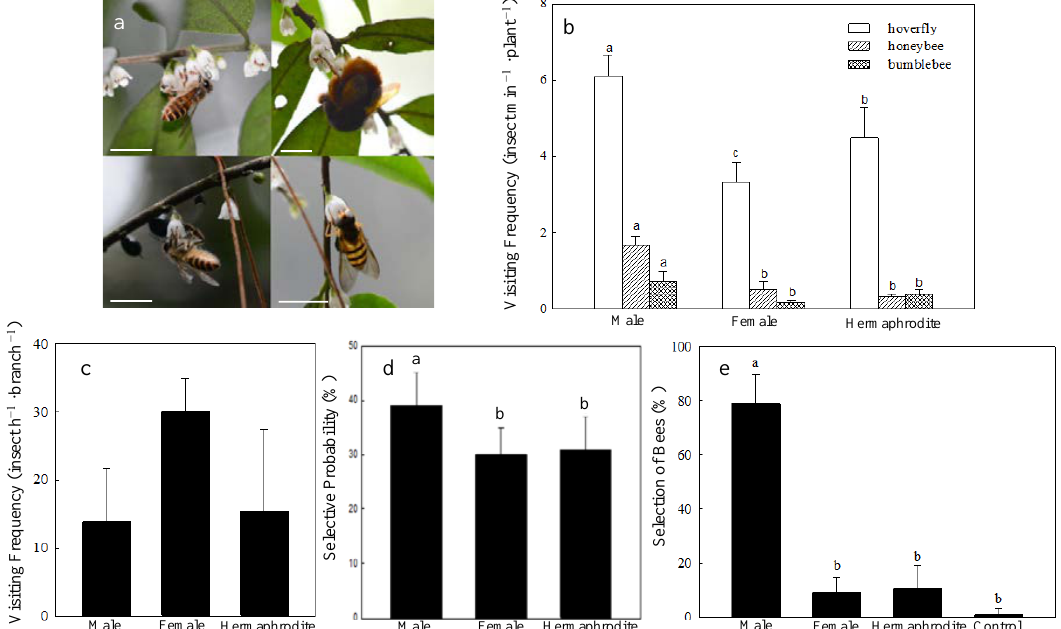
Figure 4. Main visitors of Eurya loquaiana ( a ) and their responses to different sexual types ( b – e ). ( a ) Honeybee (left), bumblebee (top right), and hoverfly (lower right), the scale bars are 10 mm. ( b ) Visiting frequency of the main visitors in the wild. ( c ) Visiting frequency in the controlled experiment. ( d ) The selective probability of visitors in the controlled experiment. ( e ) Honeybee responses to the floral scent. Different lower-case letters (a–c) above the bars indicate significant differences among sexes or treatments ( p < 0.05).